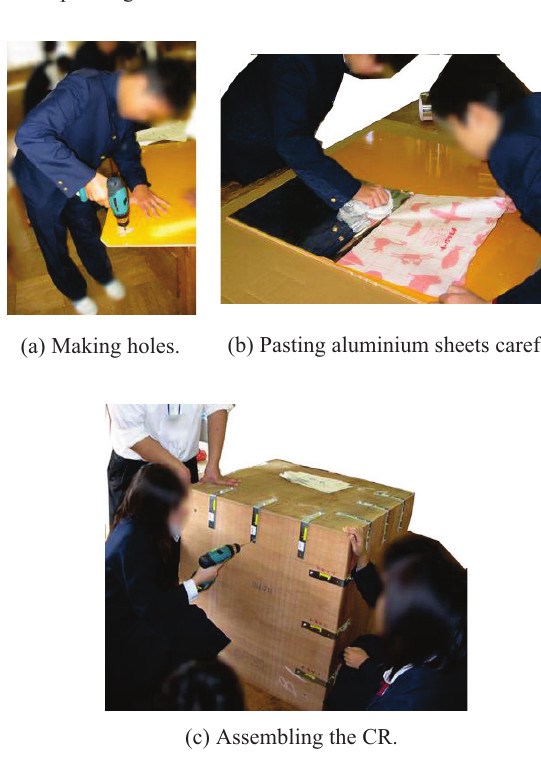
Figure 3. Students producing CR.